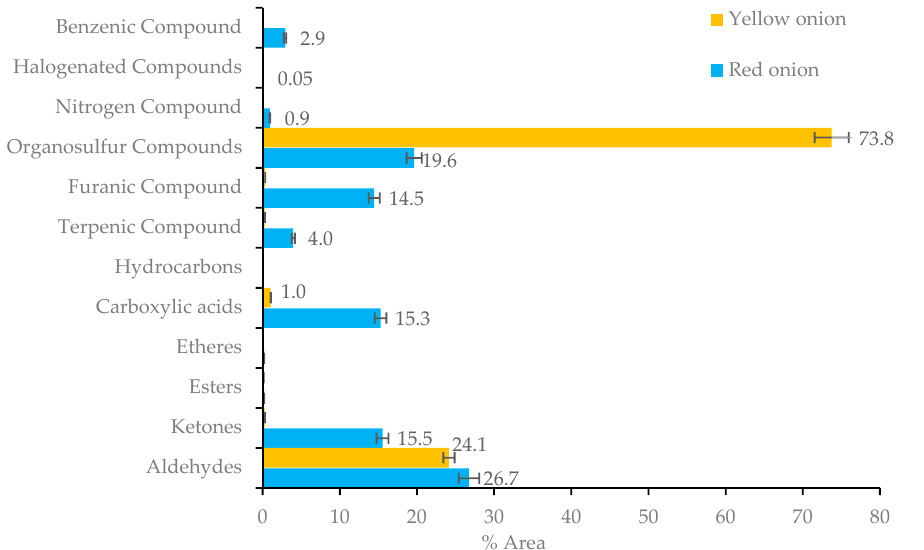
Figure 2. Distribution of chemicals identified in red and yellow onions.